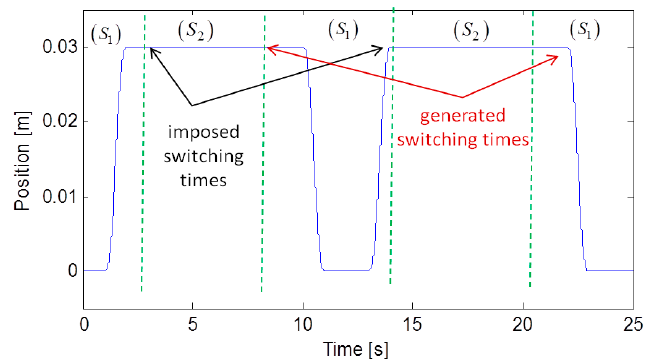
Figure 6. Evolution of the desired position.